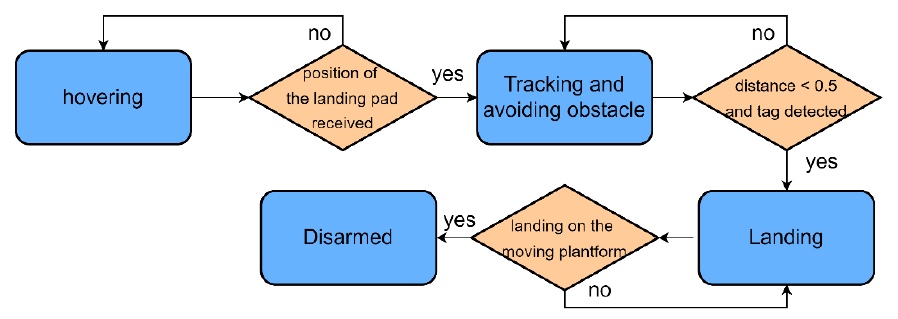
Figure 2. Finite state machine of the landing